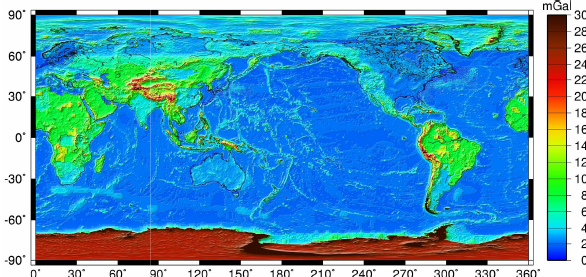
Fig. 1. The commision error of gravity anomalies of EGM2008 (re- produced from Pavlis et al., 2008a) or standard deviation of free air spherical approximation of the gravity anomalies. Scale in miligals